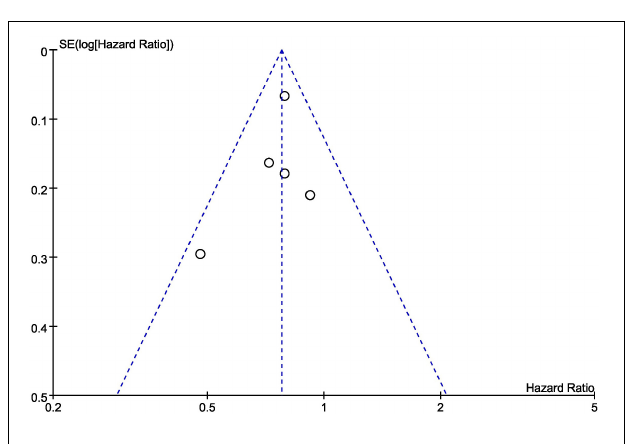
FIGURE 12 | Funnel plot of the included trials with composite of cardiovascular death or first hospitalization for heart failure